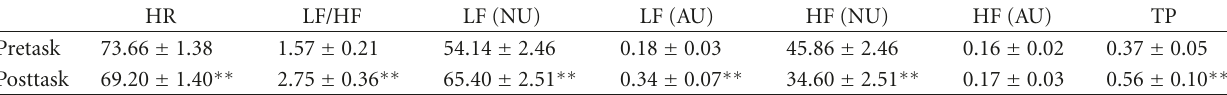
Figure 1: Schematic diagram for KPCA-HMM: (1) eye movement contamination is removed by adaptive filtering methods; (2) features of 180 dimensions are extracted using multichannel linear descriptors measure; (3) kernel PCA is used to reduce the dimensions of features; (4) two HMM’s are trained, HMM N corresponds to the norm state, and HMM F corresponds to the fatigue state; and (5) the final mental state is decided by the likelihood score of two HMM’s. Table 1: Changes of the power spectral indices of HRV after task.